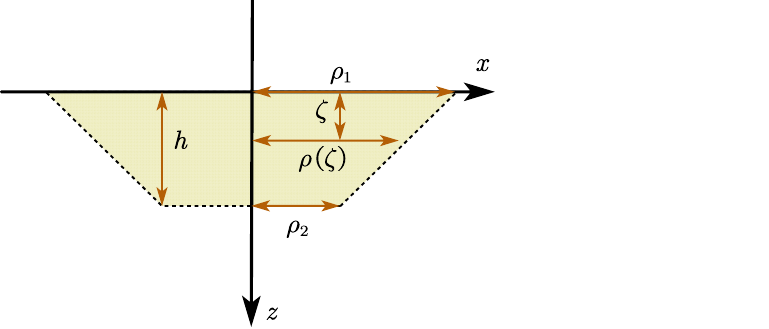
Figure 10. Cross-sectional diagram of a crater induced by a round tamper during dynamic compaction.